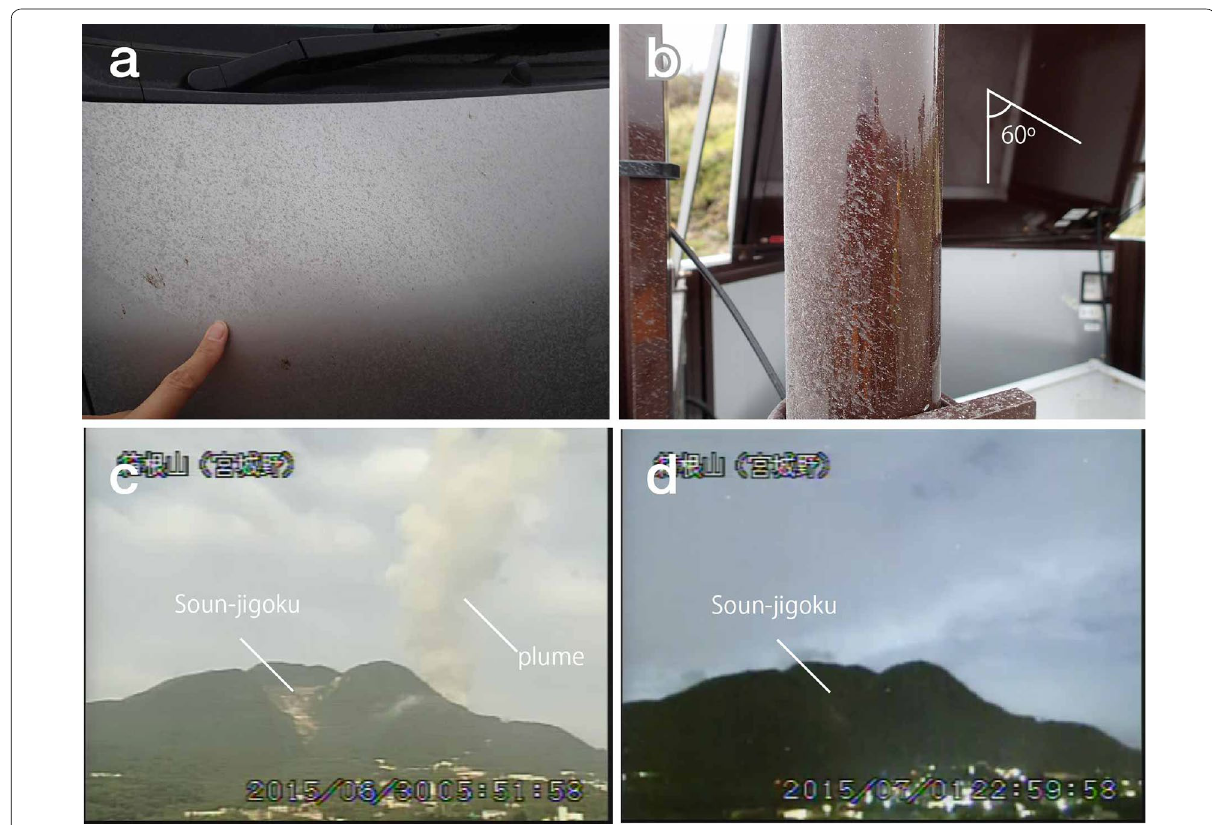
Fig. 10 Photographs taken during and after the eruption. a Ash fall on the bonnet of a car at Sounzan station (Fig. 1; 13:52 of June 29). b Ash fall on a REGMOS at Owakudani (Fig. 2; 14:40 of June 29). Note that the ash fall track is inclined. c Plume of the 2015 eruption from Miyagino, east–north- east of Owakudani at 5:51 of June 30. d Photograph taken from Miyagino at about 23:00 on July 1 shows no apparent plume above the eruption center. Photographs were taken by HSRI ( a , b ) and JMA ( c , d ). See Fig. 1 for location of the JMA live